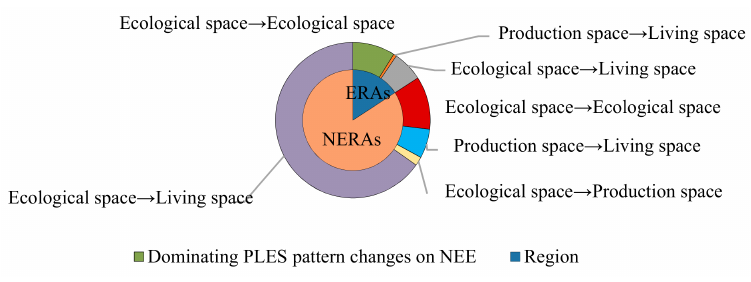
Figure 7. Ratio of dominating PLES pattern changes on NEE in the ERAs and NERAs.